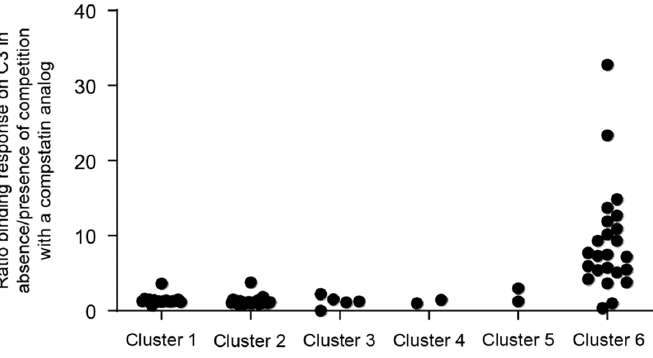
Figure A2. Nanofitin (in pAFG12) competitive binding of compstatin analogue by biolayer interfer- ometry.